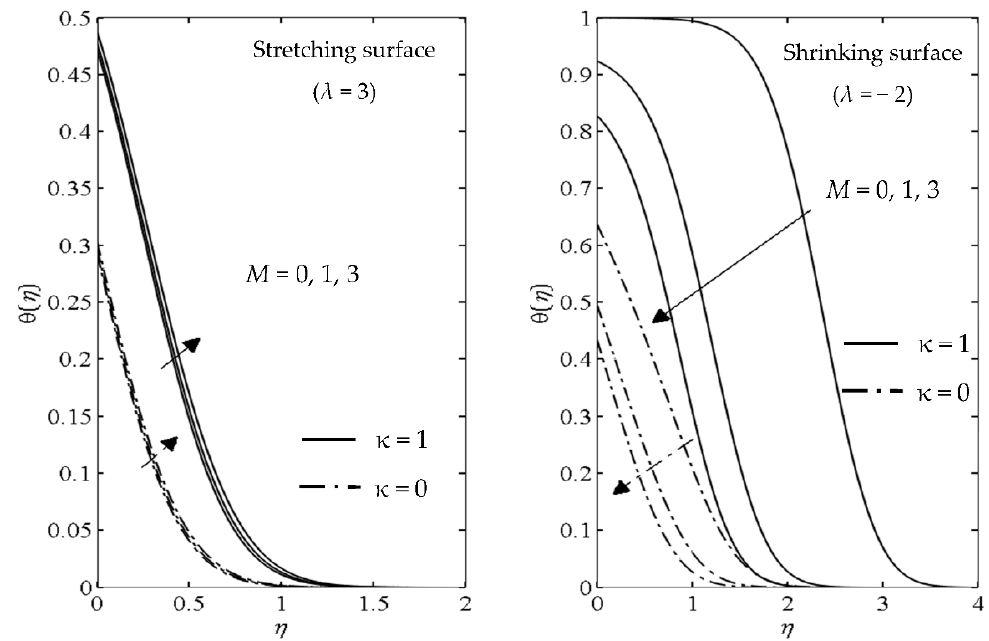
Figure 7. Effect of the magnetic interaction parameter, M , on the temperature profiles for different parameters κ and λ .